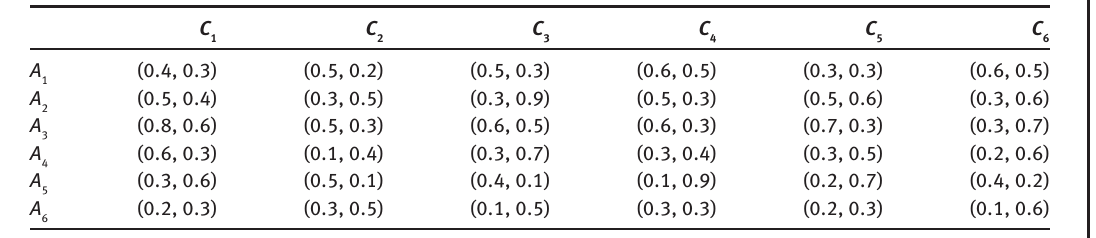
Table 2: Characterization of the Investments of Expert 2.